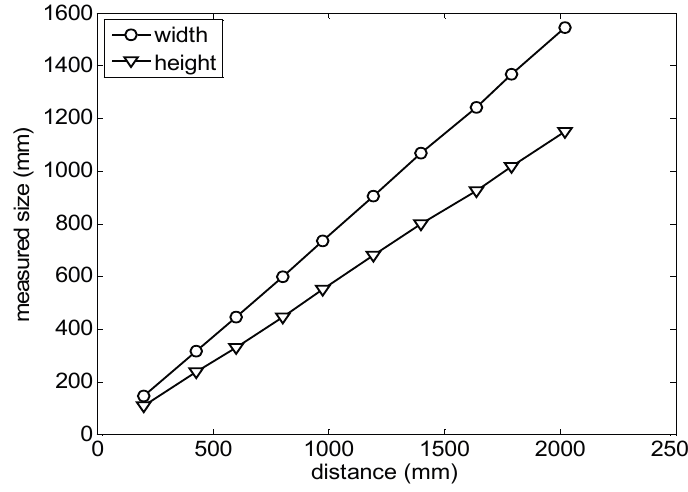
Figure 9. Grid size in function of the distance between the camera and the